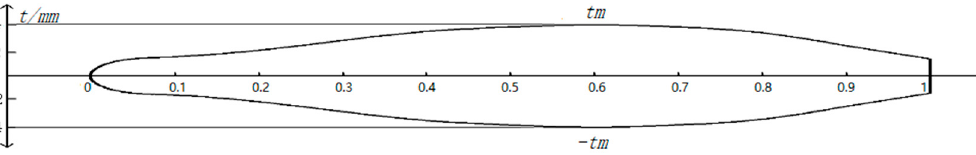
Figure 13. Blade profile.